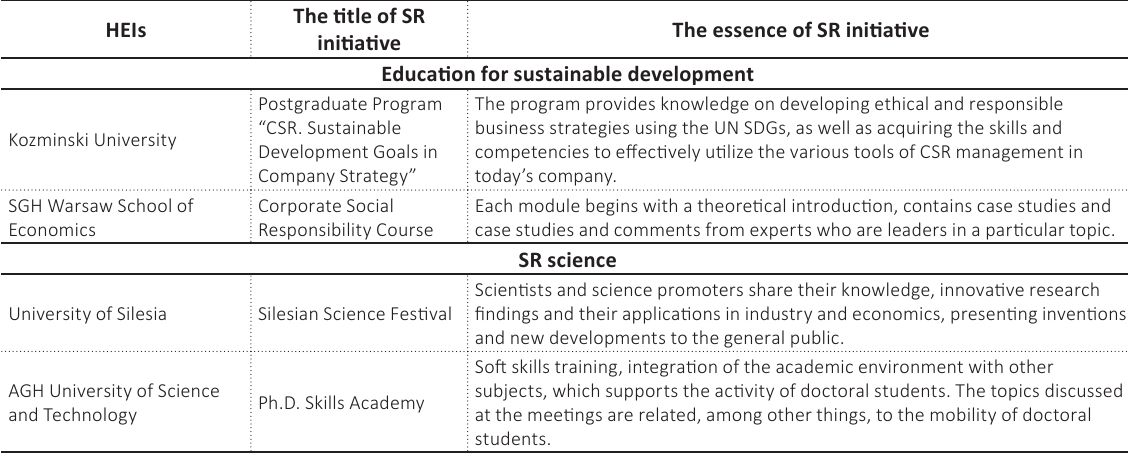
Table 9. SR examples of Polish